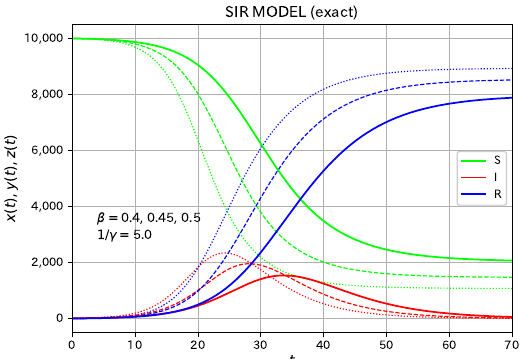
Figure 5. The exact analytical solution of the SIR model; N = 10,000, x ( 0 ) = N 1 = 9990, y ( 0 ) = 10, and z ( 0 ) = 0. Plot of the temporal variation of the susceptible (S), the infected (I) and the recovered (R) for β = 0.4 (solid), 0.45 (dashed), 0.5 (dotted) and 1/ γ = 5.0.